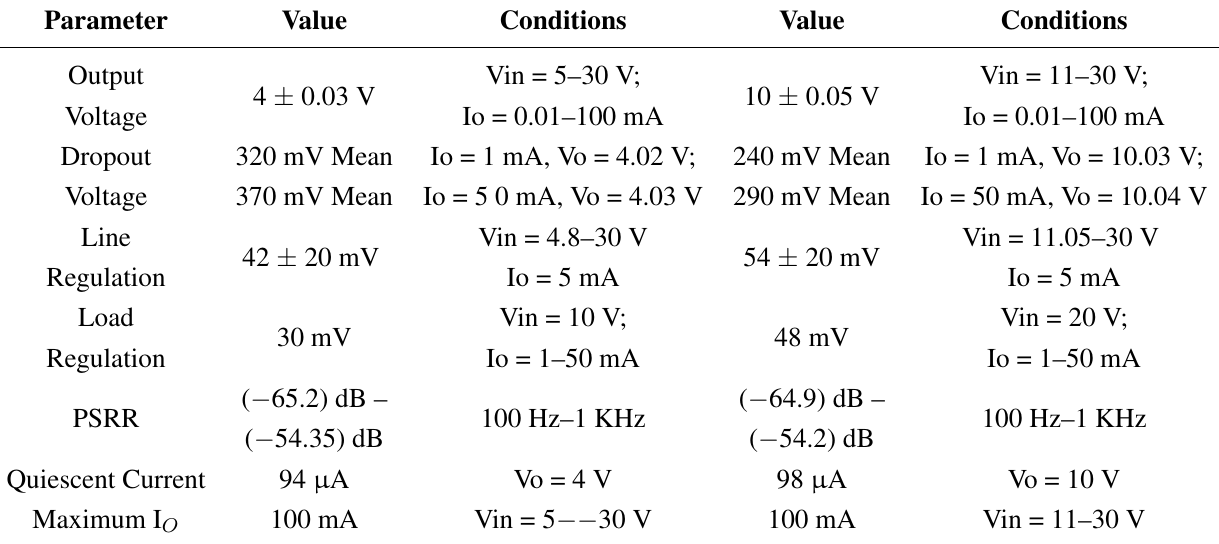
Table 3. Performance summary of the HV